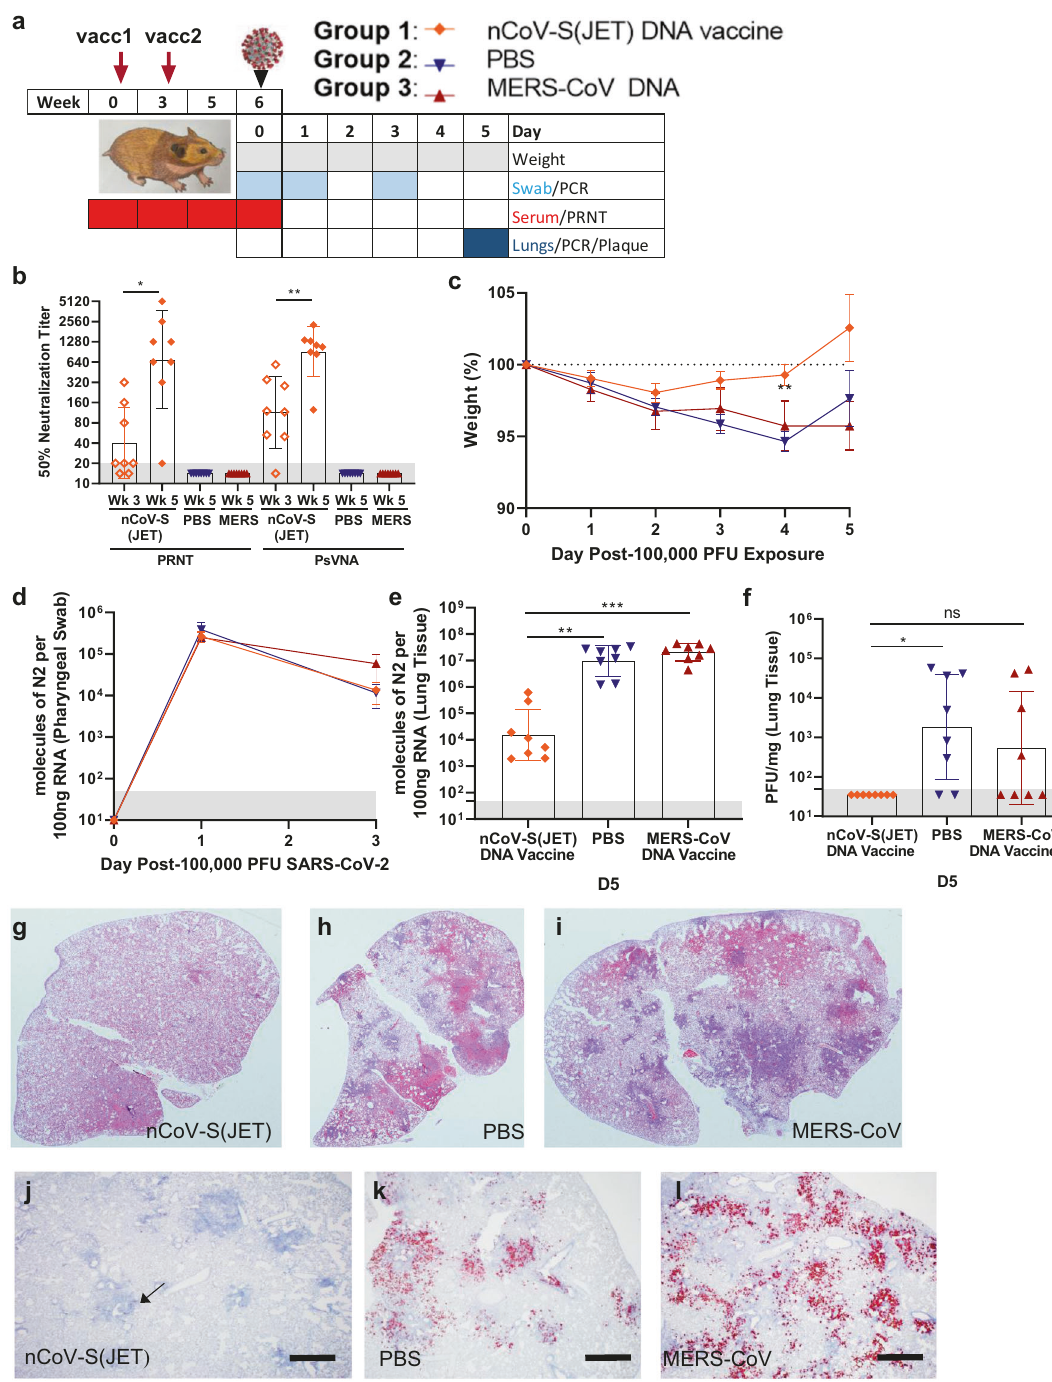
Fig. 1 Evaluation of nCoV-S(JET) DNA vaccine in Syrian hamsters. a Experimental design. Groups of 8 hamsters each were vaccinated (vacc) with the nCoV-S(JET) DNA vaccine, PBS, or a MERS-CoV DNA vaccine and then challenged with 100,000 PFU of SARS-CoV-2 virus by the intranasal route. b PRNT50 and PsVNA50 titers from serum collected at indicated timepoints after 1 (open symbols) and 2 (closed symbols) vaccinations (assay limit = 20, gray shade). Bars represent GMT ± SD. c Average animal weights relative to starting weight. Symbols represent mean ± SEM. Viral RNA in d pharyngeal swabs and e lung homogenates (assay limit = 50 copies, gray shade). Bars GMT ± SD. f Infectious virus as measured by plaque assay (assay limit = 50 PFU, gray shade). Bars GMT ± SD. Bright fi eld imagery of H&E staining of lung sections from g nCoV-S(JET) DNA, h PBS, or i MERS-CoV vaccinated hamsters where purple indicates areas of consolidation. ISH to detect SARS-CoV-2 genomic RNA in lung sections of j nCoV-S(JET) DNA, k PBS, and l MERS-CoV vaccinated hamsters. Rare, positive labeling in nCoV-S(JET) DNA vaccinated hamster lung sections were detected (arrows). Asterisks indicate that results were statistically signi fi cant, as follows: * p < 0.05; ** p < 0.01; *** p < 0.001; ns not signi fi cant. Scale bars = 400 microns. Hamster drawing was provided by Jake Hooper (hjake@vt.edu), with